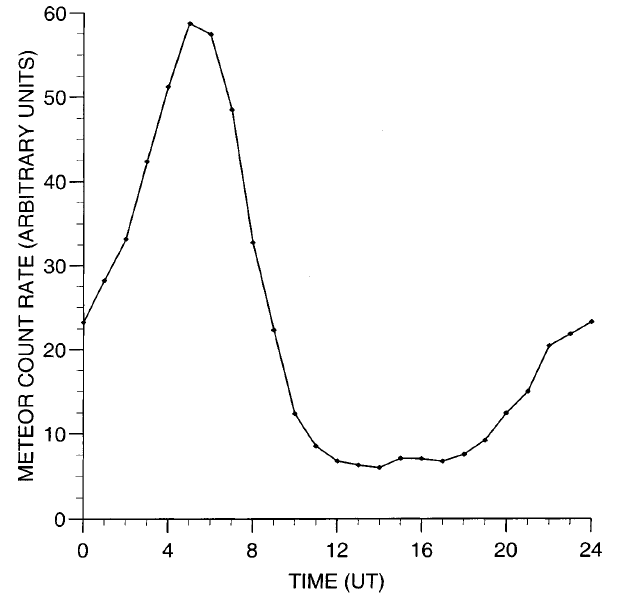
Fig. 1. The diurnal cycle in meteor count rates based on all meteors recorded in 1992. Data from both aerial directions